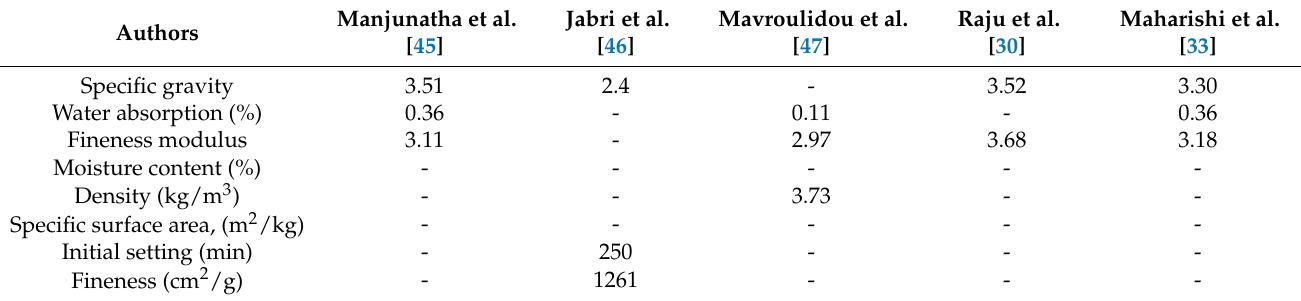
Table 1. Physical Aspects of CPS.